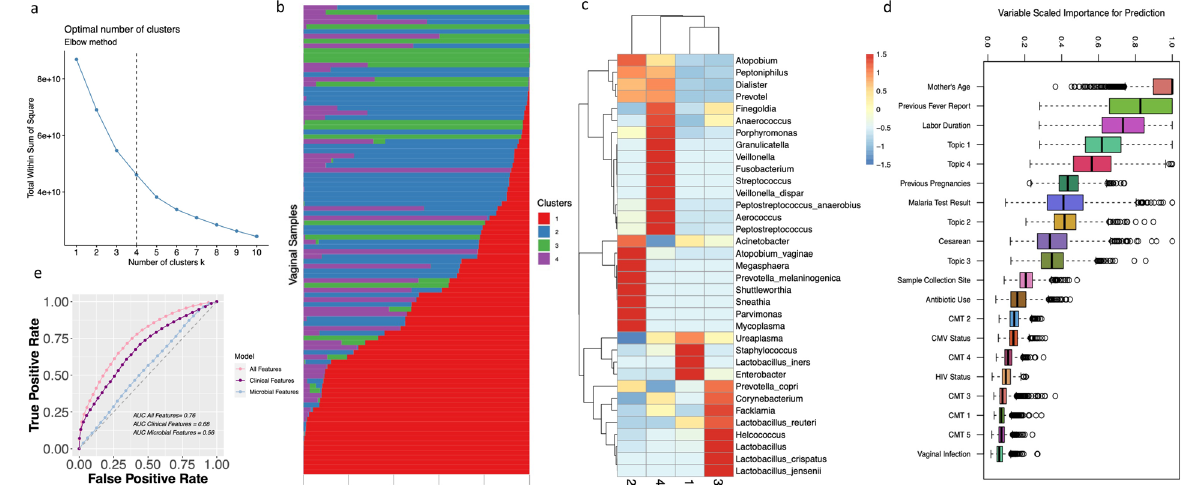
Fig. 5 GoM models and random forest for maternal febrile status prediction. a Cluster number determination for the data set utilizing the elbow method, which maximized the variance of rate of decline changes as a second derivative. b The sample weight value ( ω ) of the topic model for the V3 – V4 data set. Every row represents a participant ’ s vaginal swab sample. Every color represents the ratio in which the sample belongs to that particular cluster determined by the model. c Theta ( θ ) value for every feature (on species taxonomic rank) contributing to the formation of the clusters of GoM models. The heatmap score is a row wise z -score normalized value for every feature in each cluster. d Feature importance for maternal fever status determination utilizing clinical features in addition to topic model clusters and communities identi fi ed by hierarchical clustering result of 1000 rounds of random training and test set modeling (CMT 1 – 5 denote communities identi fi ed in hierarchical clustering formatted as binary 1 – 5 (present absence feature) feature. e Receiver operator curve (ROC) for 1000 rounds of random resampling of training and test set of the RF model for maternal fever status identi fi cation using all (both clinical and microbial features), clinical, and microbial